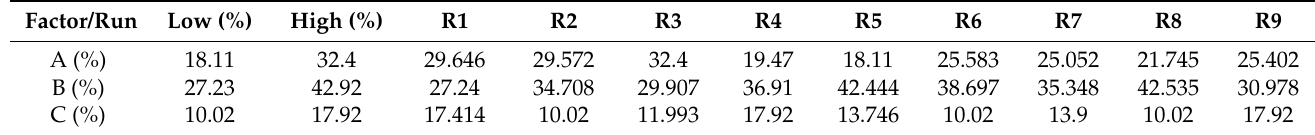
Table 1. Design for mixture